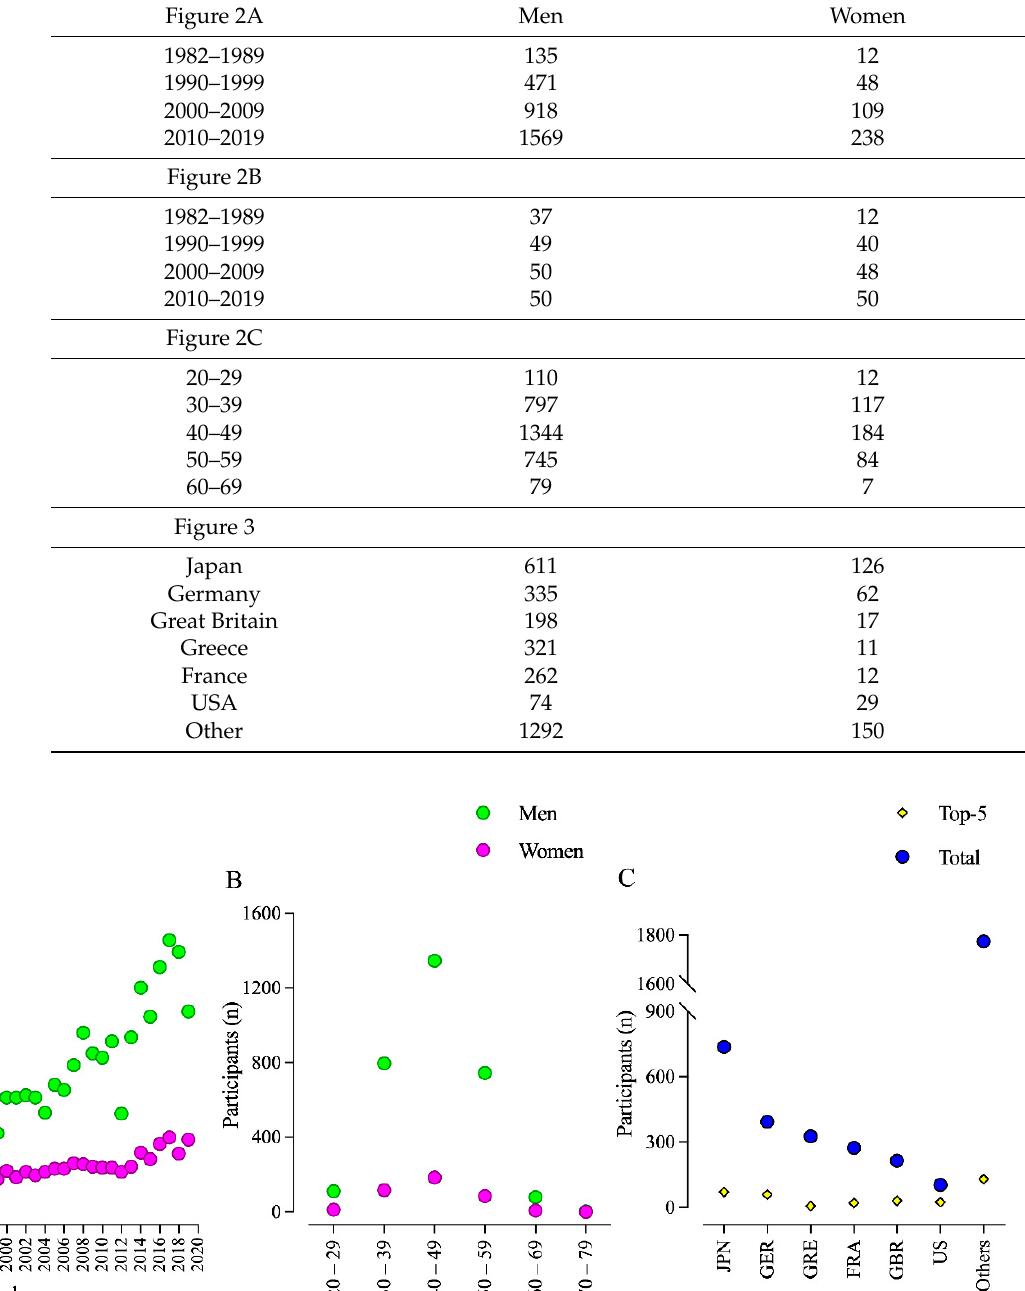
Table 1. Number of participants in each subgroup of the ANOVA analyses. Data presented as n .